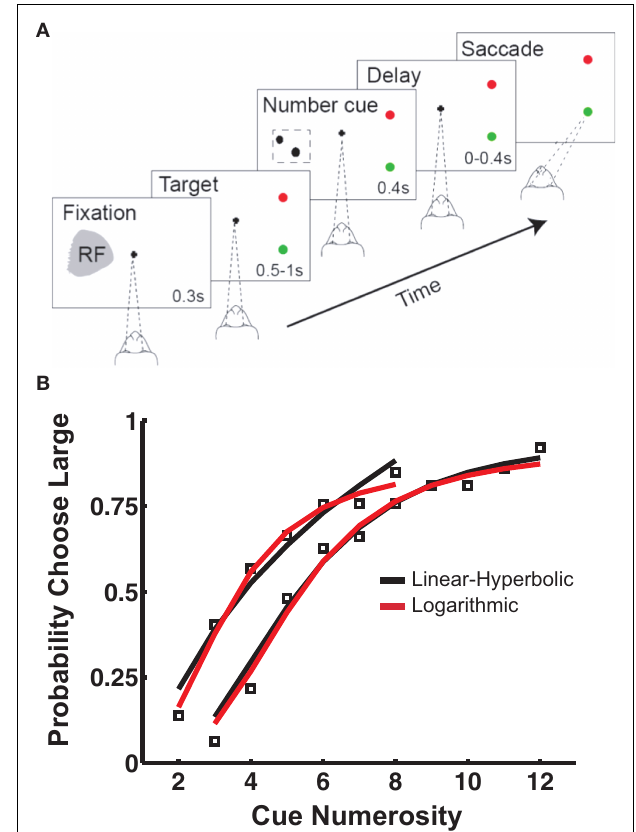
FIGURE 1 | Numerosity bisection task. (A) Schematic showing modeled oculomotor bisection task. Following fi xation, two saccade targets appear: red for “small” and green for “large.” After a variable delay, a dot array is briefl y presented in the recorded neuron’s response fi eld. Following a second variable delay, the fi xation target extinguishes, and the animal makes an eye movement to either choice target in the hemifi eld opposite the neuron’s RF. (B) Choice behavior and model fi ts to a touch screen version of the numerosity bisection task (after Jordan and Brannon, 2006). Data points represent probability of choosing the response associated with the “large” anchor value. Red and black lines indicate fi ts based on families of choice curves derived from the linear-hyperbolic and logarithmic encoding models. Anchor values are 2 and 8 for the left set of curves, 3 and 12 for the